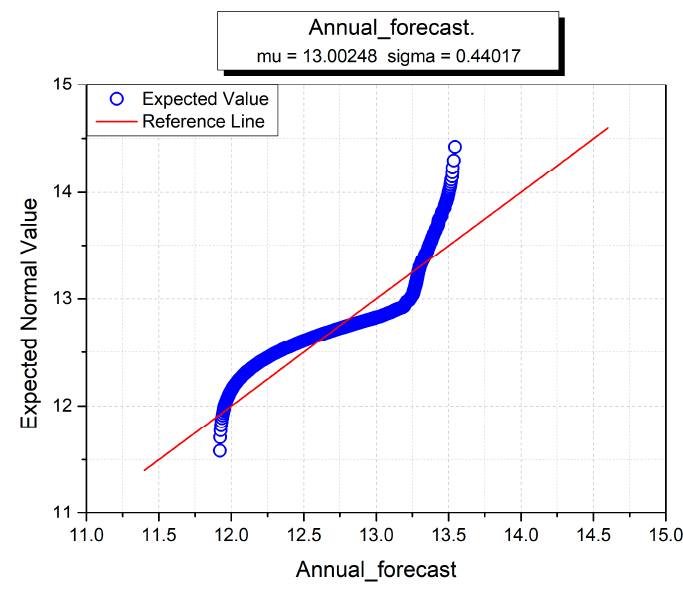
Figure 17. Annual normal distribution for wind power forecasting.